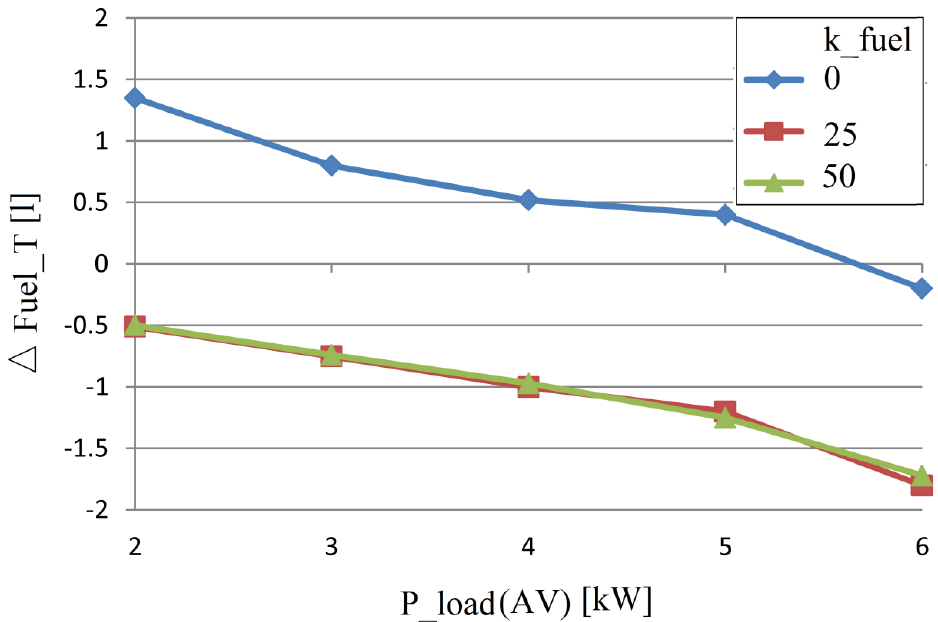
Figure 13. Fuel economy for the RTO2 strategy in case A ( k fuel = 0), B ( k fuel = 25), and C ( k fuel = 25) under variable load.